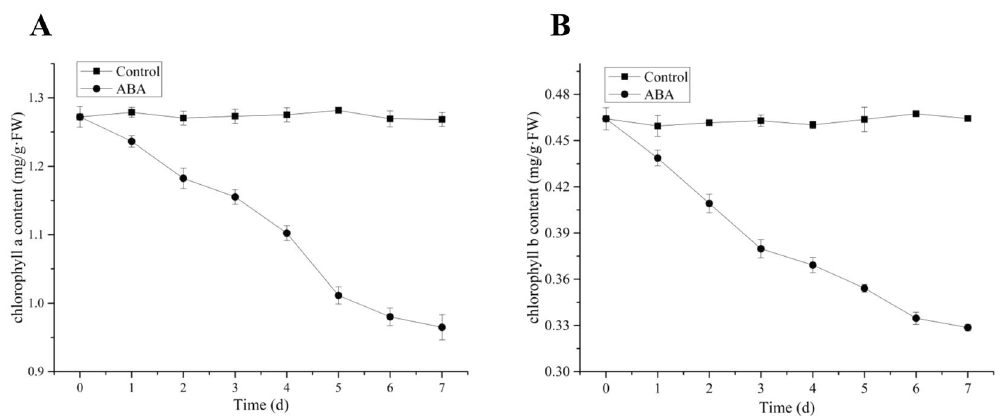
Figure 3. Chlorophyll a and chlorophyll b content of L. punctata . ( A ) Chlorophyll a content. ( B ) Chlorophyll b content. Values are given as the mean ± SD of three experiments for each